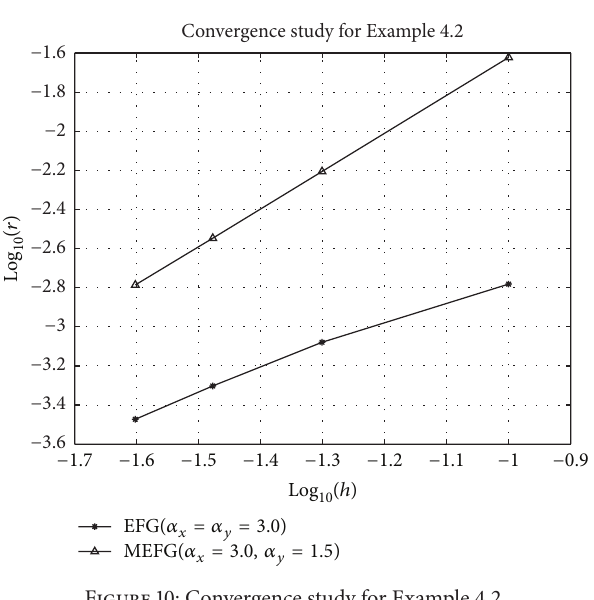
Figure 10: Convergence study for Example 4.2.